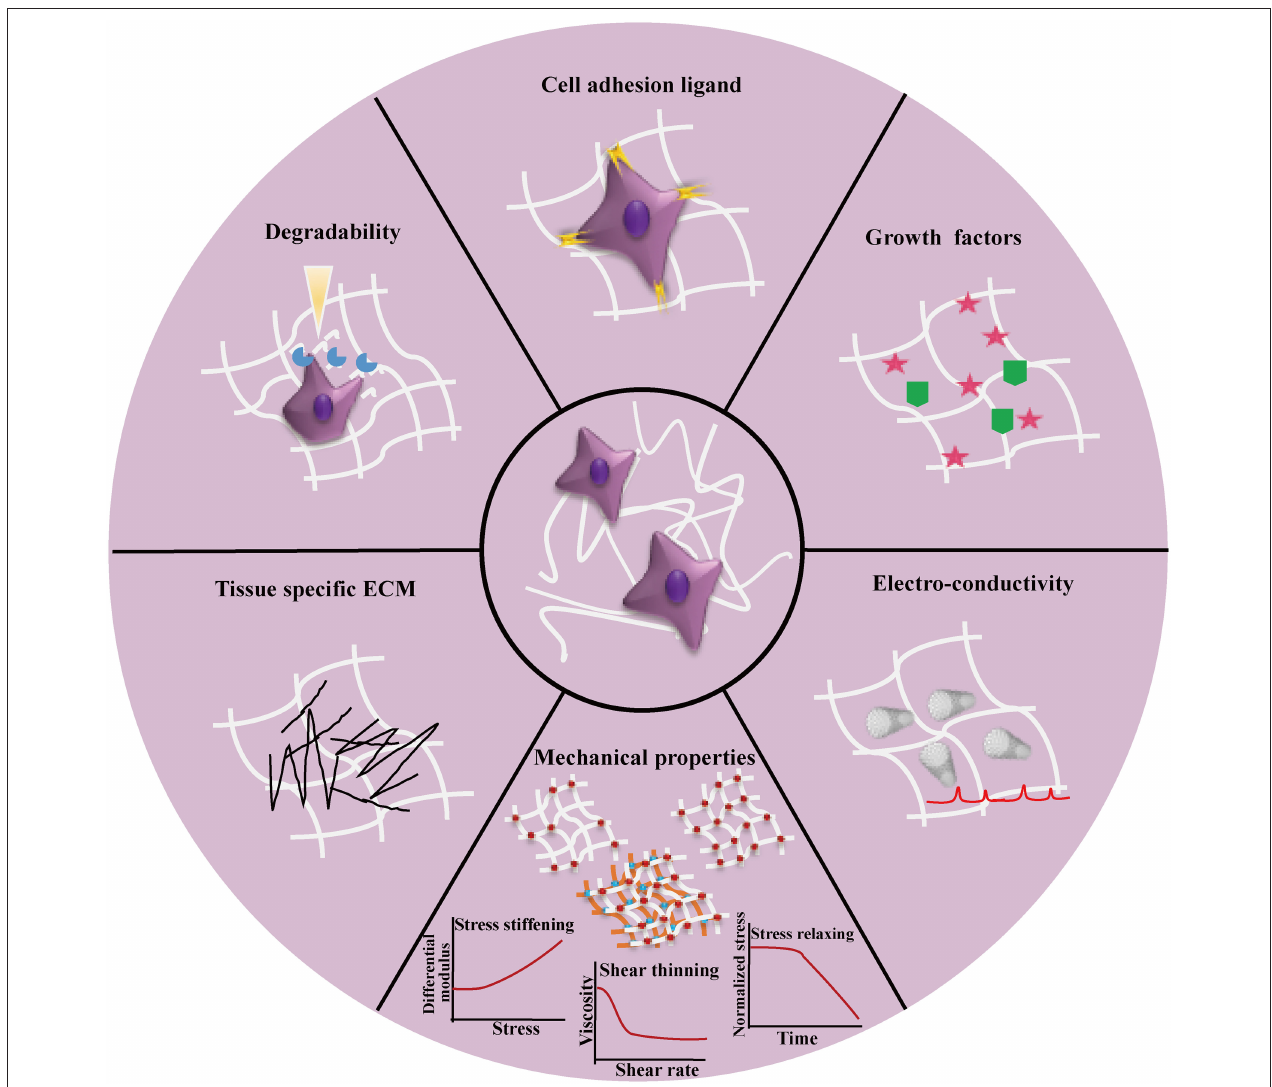
FIGURE 5 | Overview of the design considerations for recreating 3D cell microenvironment in vitro by using composite hydrogels to fully mimic the features of native tissues. The design considerations can generally be divided into two tracks, i.e. biochemical (e.g., cell adhesion ligands, soluble factor immobilization and tissue specific ECM involvement) and biophysical design considerations (e.g., mechanical properties including tuneable strength requirements by crosslinking and involvement of multiple interpenetrating networks, stress-relaxing, stress-stiffening, degradability, and electrical